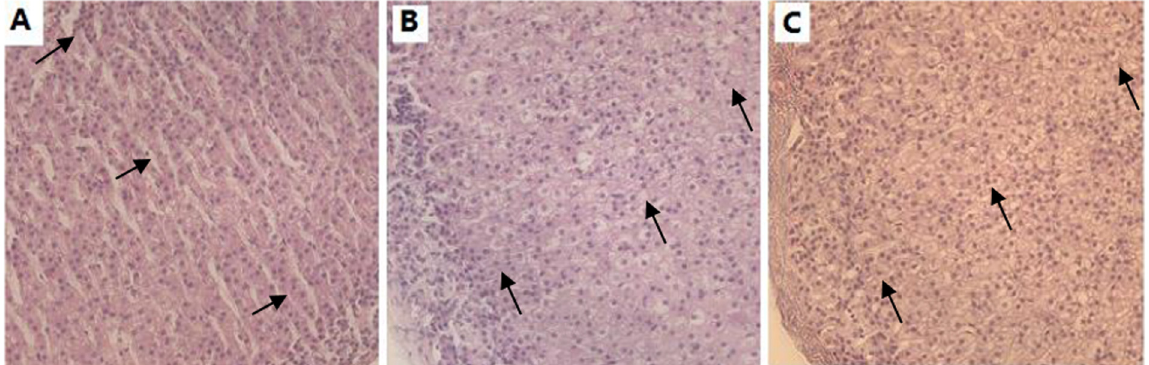
Fig 8. Representative HE staining of adrenal gland (200 ×). Sections from control group (A), TDBP-TAZTO 5 mg/kg group (B) and TDBP-TAZTO 50 mg/ kg group (C). The arrows indicates zona fasciculata. The regularly arranged long columnar cells without cell hyperplasia or hypertrophy were observed in the zona fasciculata in the control group (A). Main diffuse adrenal hyperplasia and hypertrophy of the zona fasciculate were noted in 5 and 50 mg/kg groups (B and